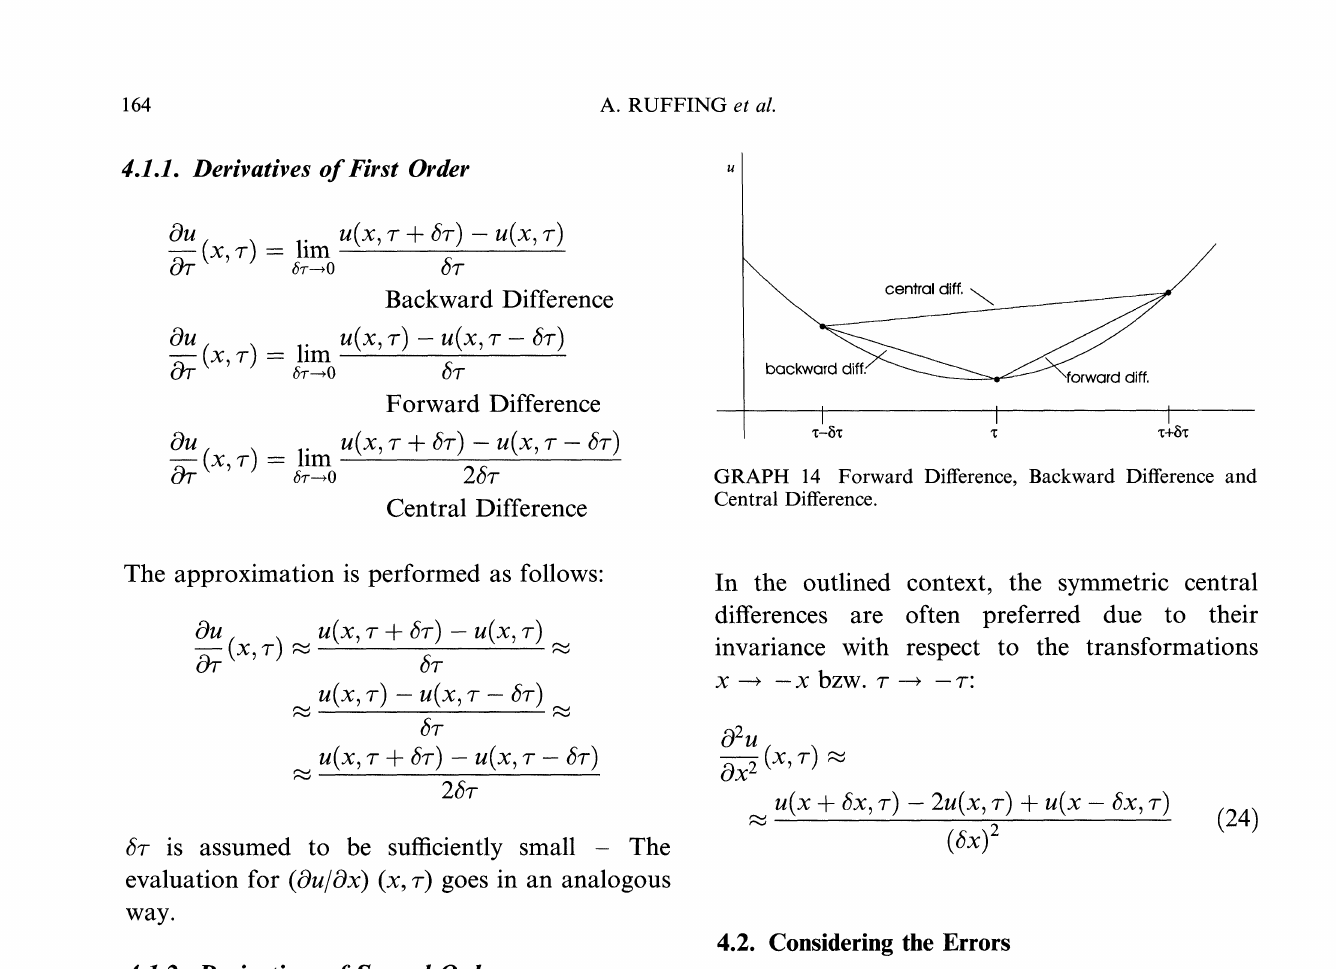
Central Difference